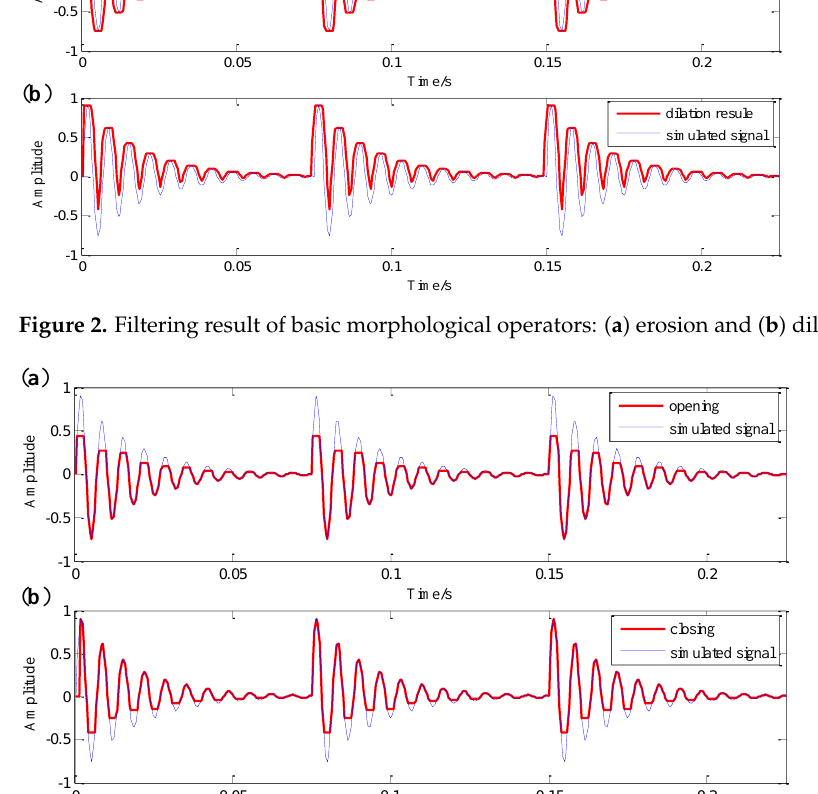
Figure 4. Filtering result of gradient operator. 2.2. The Proposed Method for Fault Detection The main purpose of this paper is to improve the denoising ability of a morphological filter facing heavy noise in fault diagnosis for shipborne antenna drivetrains. Literature shows that the result of noise reduction highly depends on the length of a structuring element. Therefore, an adaptive structure optimization methodology is proposed in the paper, and the procedure is introduced as follows. 2.2.1. The Procedure of the Proposed Method The flow diagram of the proposed method is shown in Figure 5. Firstly, once a raw signal is collected, the maximum of the element length is defined. Secondly, the raw signal is filtered by using a gradient operator of unequal length, and its spectrum is expressed in scale domain. Thirdly, the spectrum is divided into several sub-bands, and each sub- band is corrected according to its center frequency. Then, the characteristic energy ratio 0